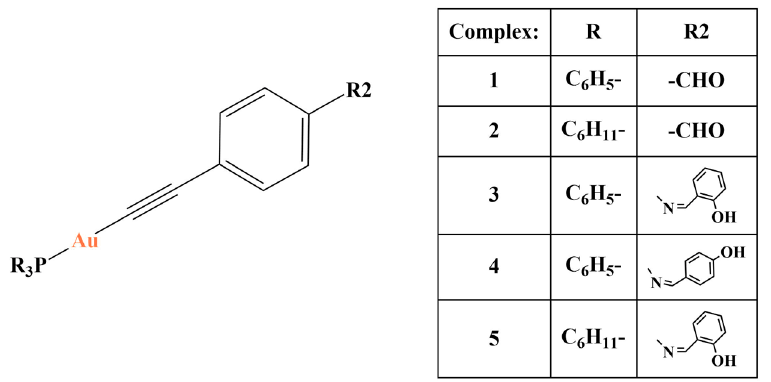
Figure 31. One of the complexes presented in [114].